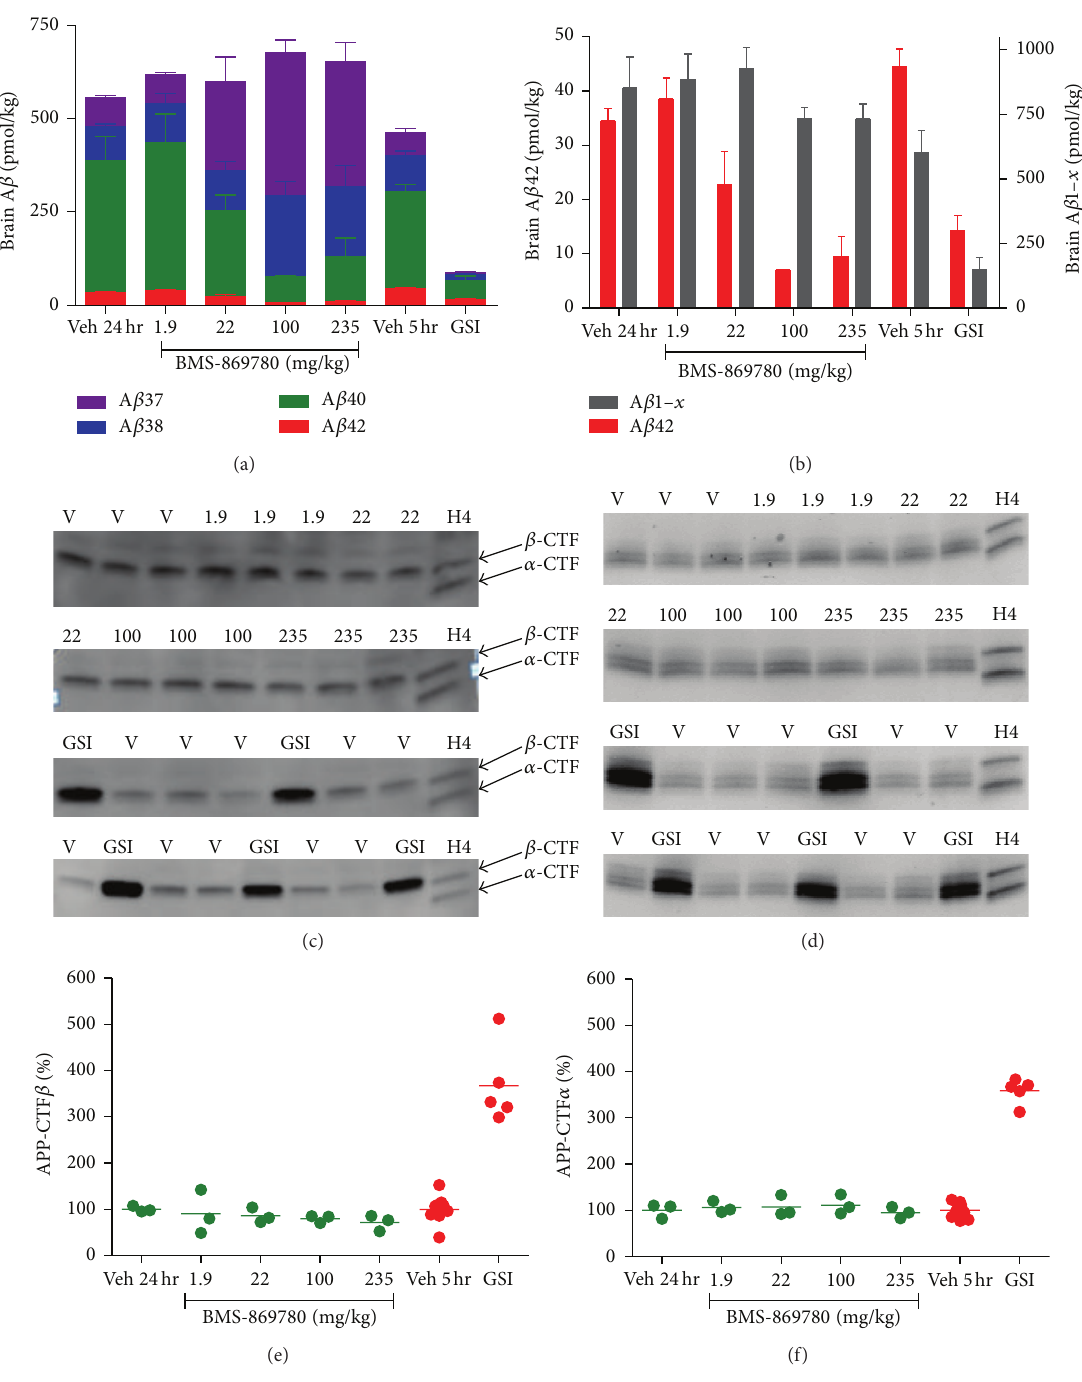
Figure 5: BMS-869780 modulated A 𝛽 but did not cause accumulation of 𝛽 CTF or 𝛼 CTF in rat brain. Rats were given oral doses of BMS- 869780, and levels of brain A 𝛽 , 𝛽 CTF, and 𝛼 CTF were determined 24 hours later. For comparison, BMS-698861 was dosed in a separate experiment and samples were taken 5 hours later. (a) Brain levels of A 𝛽 1-42 (red), A 𝛽 1-40 (green), A 𝛽 1-38 (blue), and A 𝛽 1-37 (purple) are shown as bars stacked upon one another. The total height of each bar therefore represents the sum of the four peptides. (b) A 𝛽 1-42 (red—left Y axis) and A 𝛽 1- x (grey—right Y axis). The same results for A 𝛽 1-42 are plotted in both (a) and (b). (c) Rat brain 𝛽 CTF was detected by western blottingofimmunoprecipitatesfromsamplesofthesameratbrainsusedforA 𝛽 determinations.V,vehiclegroups;resultsfromratsdosedwith 1.9, 22, 100, and 235 mg/kg of BMS-869780 and 10mg/kg BMS-698861 (GSI) are indicated. (d) Western blots of immunoprecipitated 𝛼 CTF from the same rat brain samples. (e) and (f) quantification of western blots shown in (c) and (d), respectively, expressed relative to percent of average level of CTF in vehicle-treated rats. Actual doses of BMS-869780 were determined by analysis of concentrations in left-over dosing